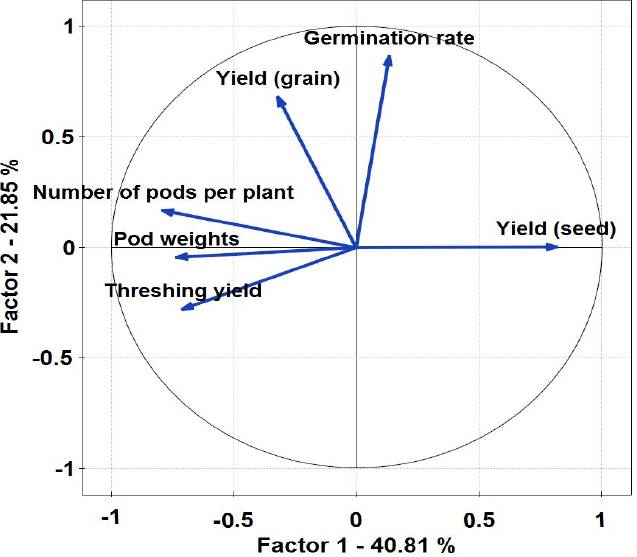
Figure 4. PCA for the studied parameters. The most important factors were germination rate and seed yield. Kaiser-Mayer-Olkin (KMO) coefficient 0.62; p < 0.001.